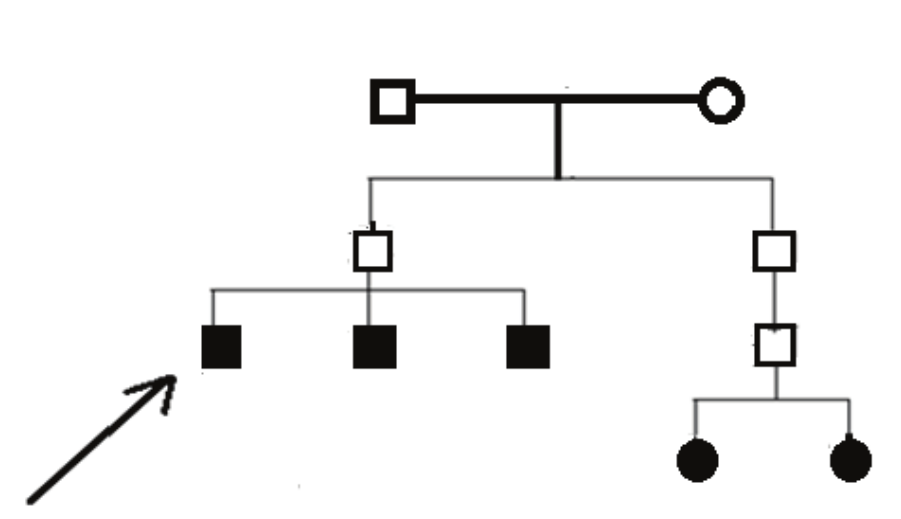
Figure 4 : Pedigree of the fourth family from the Northern State, Sudan with familial Bell’s palsy with five (three male and two female) affected individuals across two generations. The black arrow shows the index